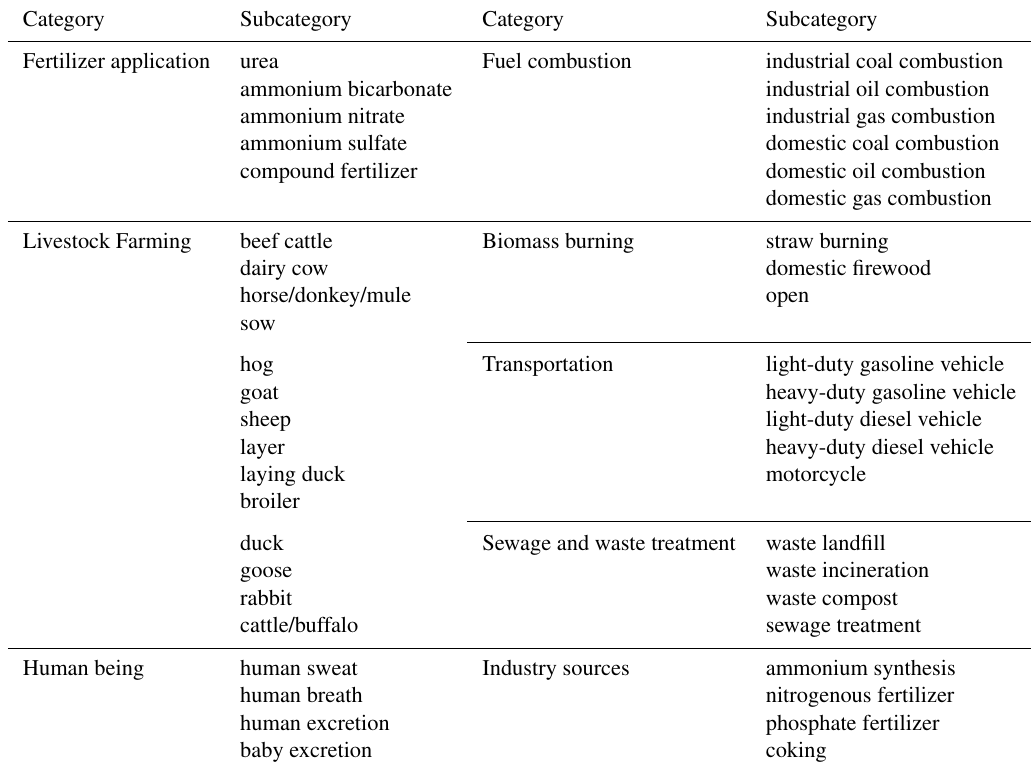
Table 1. Anthropogenic NH 3 emission source